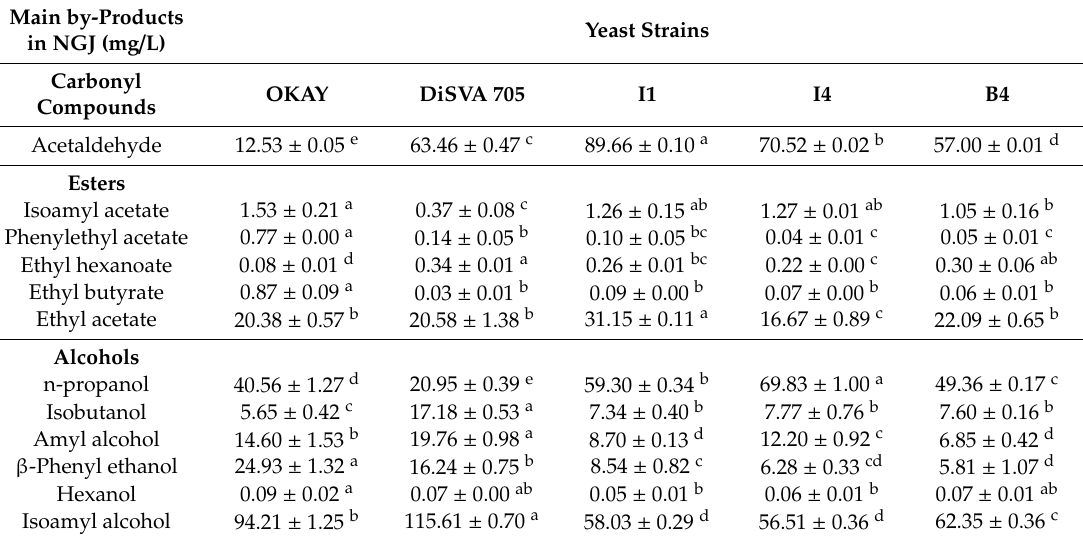
Table 4. Main fermentation byproducts and volatile compounds in